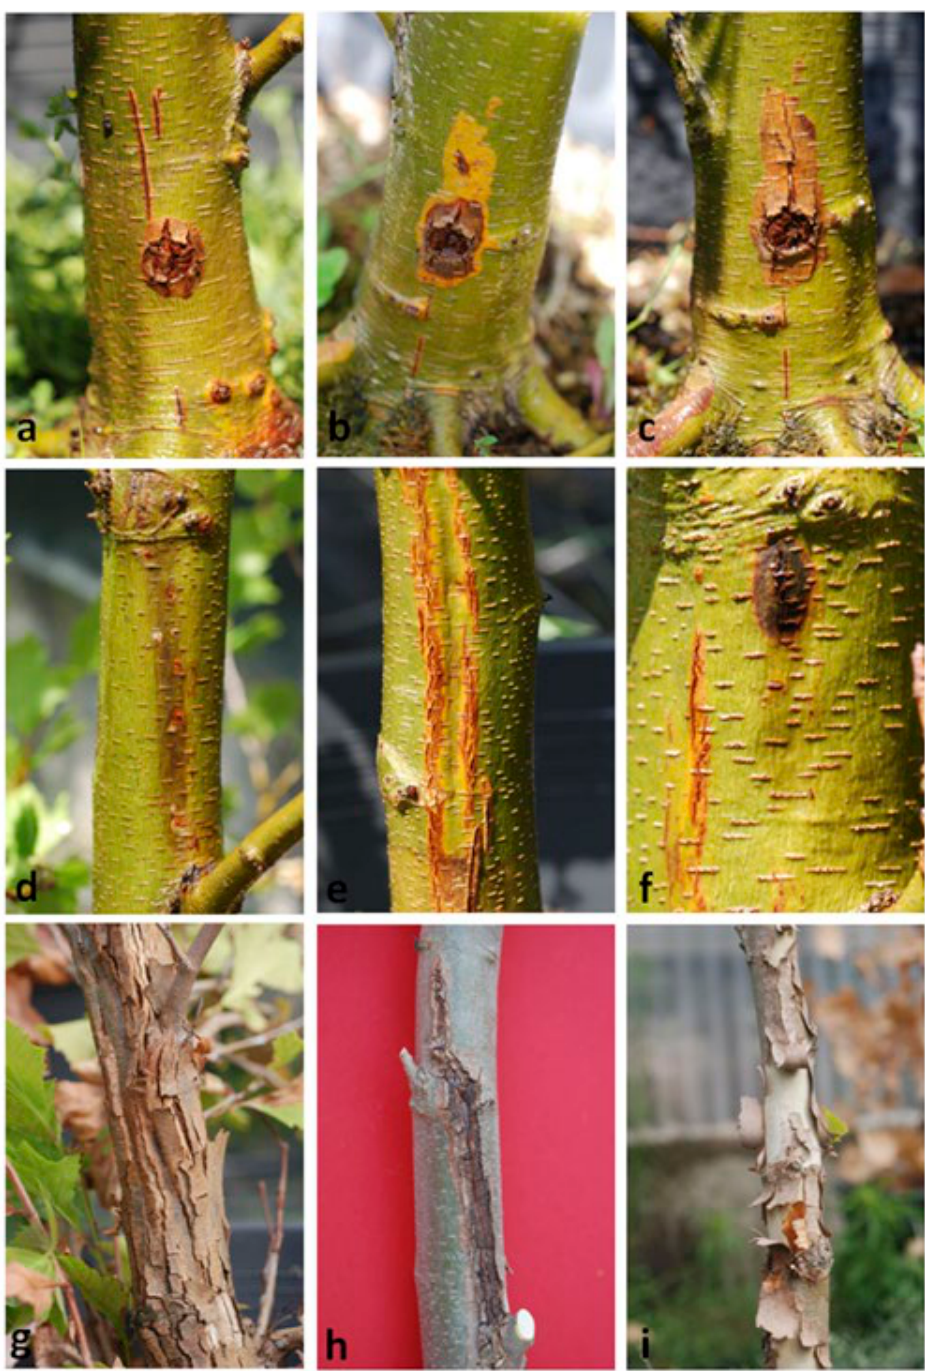
Figure 4. Stem canker on Platanus × acerifolia trees that have been artificially infected with Phytophthora cinnamomi . Bark cracks near the inoculation point (a, b, c). Yellow discolouration spreading from the inoculation point and turning into an exfoliating, brown and dried patch of tissue (b vs c). Dark staining of the bark (d). Surface, and corky cracking surround- ing the edges of a longitudinal bark canker (e). A damp, black blotch (f). Callus reaction on a cankered stem, 2 years after Phytophthora cinnamomi inoculation (g, h). Rhitidome exfoliation in a portion of the stem far from the cankered areas